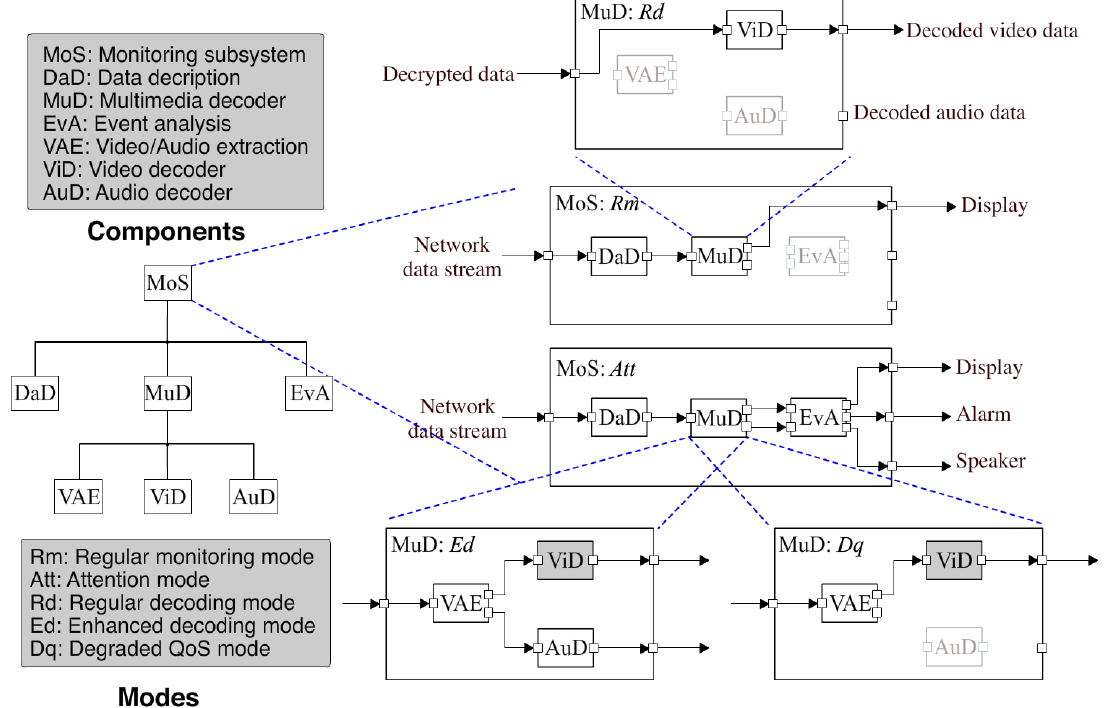
Figure 1. The architectural model of a multi-mode system built from multi-mode